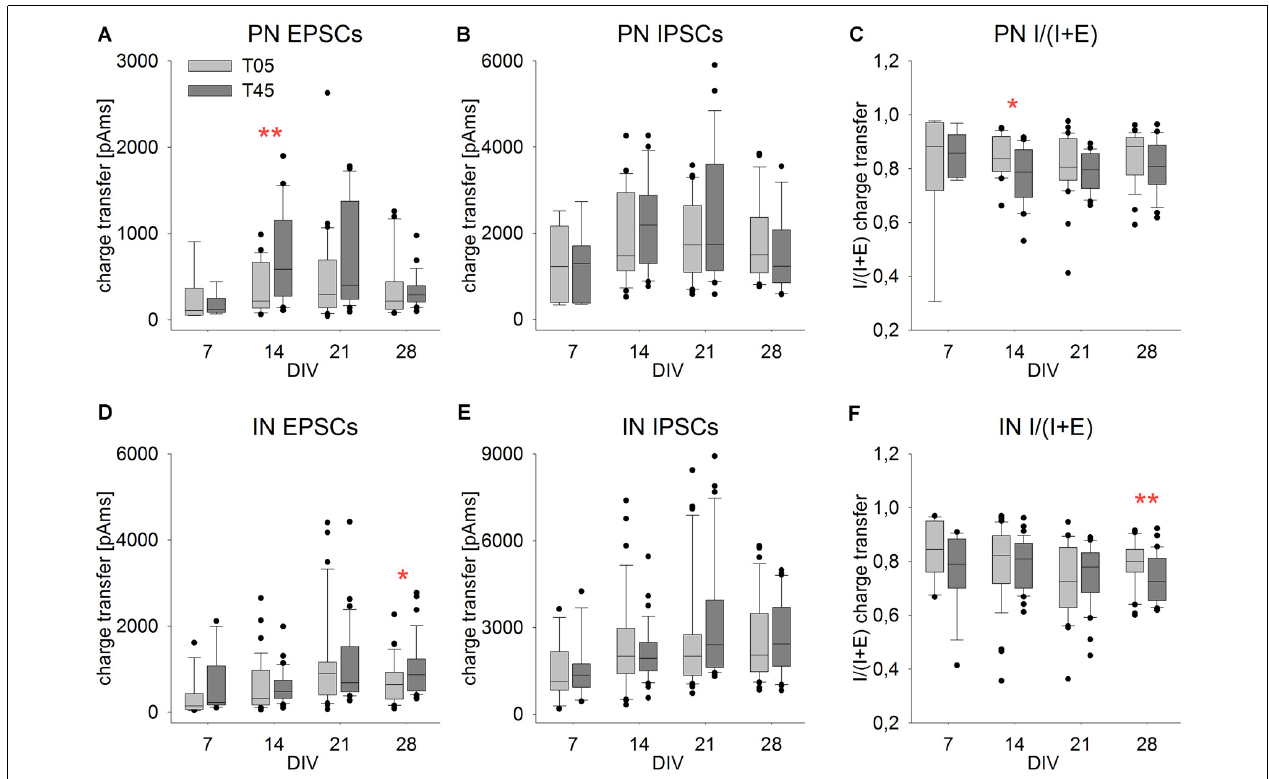
FIGURE 10 | Isolated PSCs charge transfer ratio showed little variation in development and between networks. Graphs show the development of the single events PSC charge transfer and charge transfer ratio [I/(I + E)] in PNs (A–C) and INs (D–F) in T05 (light gray boxes) and T45 (dark gray boxes) networks over time. Compared with network bursts (Figures 8G–L) , single PSCs charge transfer differed considerably less over age and between network types. Asterisks indicate significant differences between network types (* P ≤ 0.05, ** P ≤ 0.01). For the number of cells and statistically significant age differences see Table 2